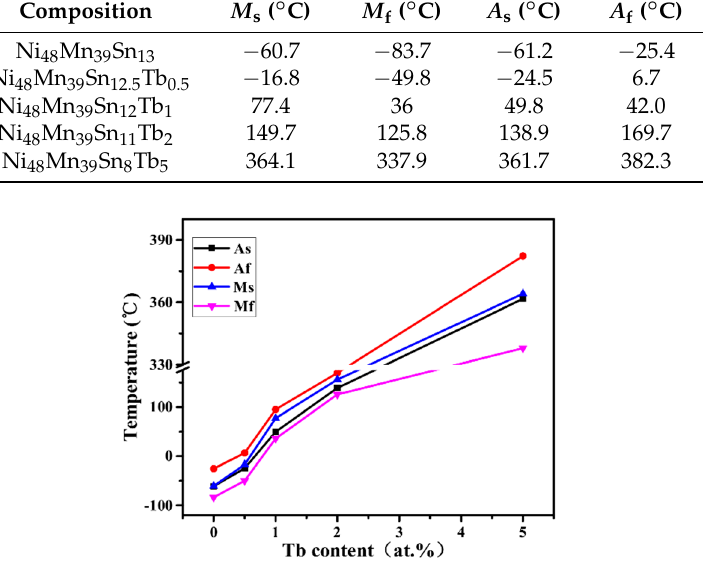
Figure 5. The effect of Tb content on the phase transformation temperatures of Ni 48 Mn 39 Sn 13 − x Tb x ( x = 0, 0.5, 1, 2, 5) alloys.